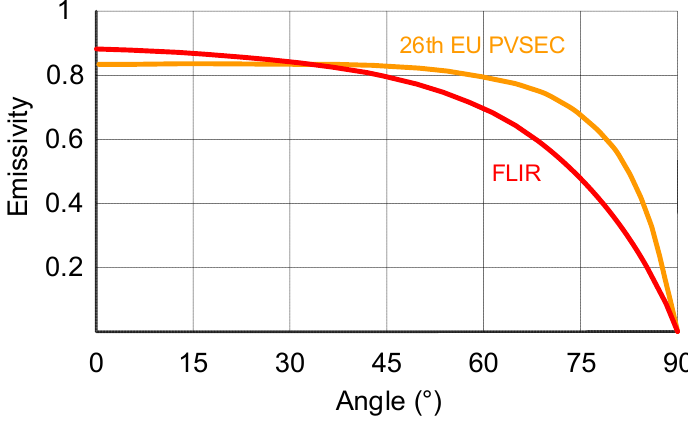
Figure 11. Emissivity of glass as a function of reflection angle. The analysis of all previous findings, presented in [10], from the emissivity spectrum can be seen in Figure 12.